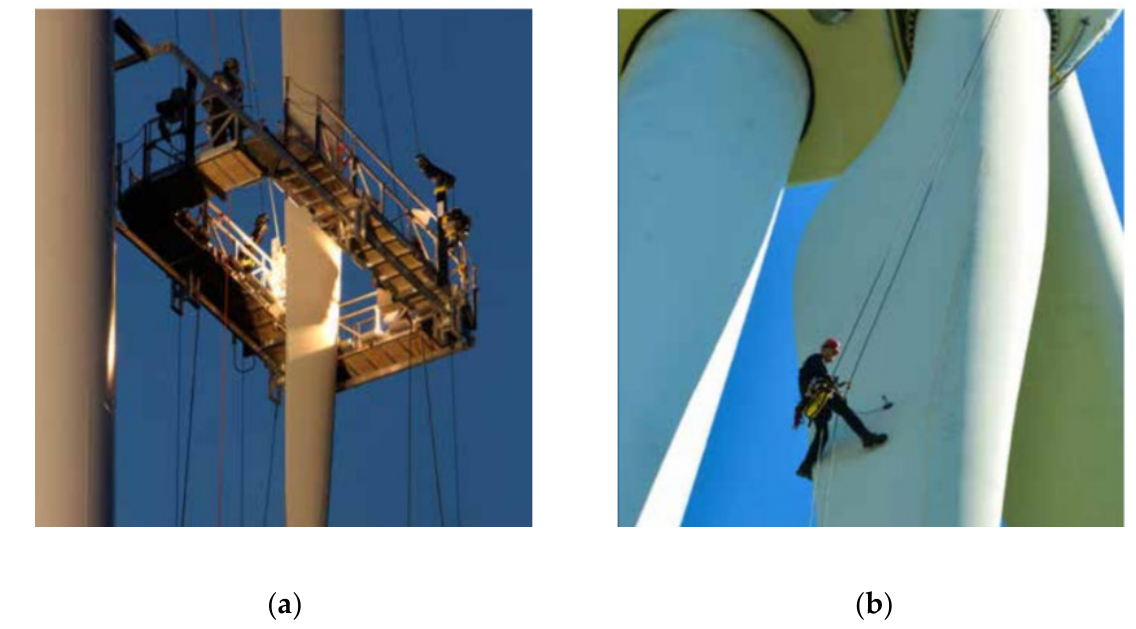
Figure 8. Visual inspection on platform ( a ), on rope ( b ) [36].